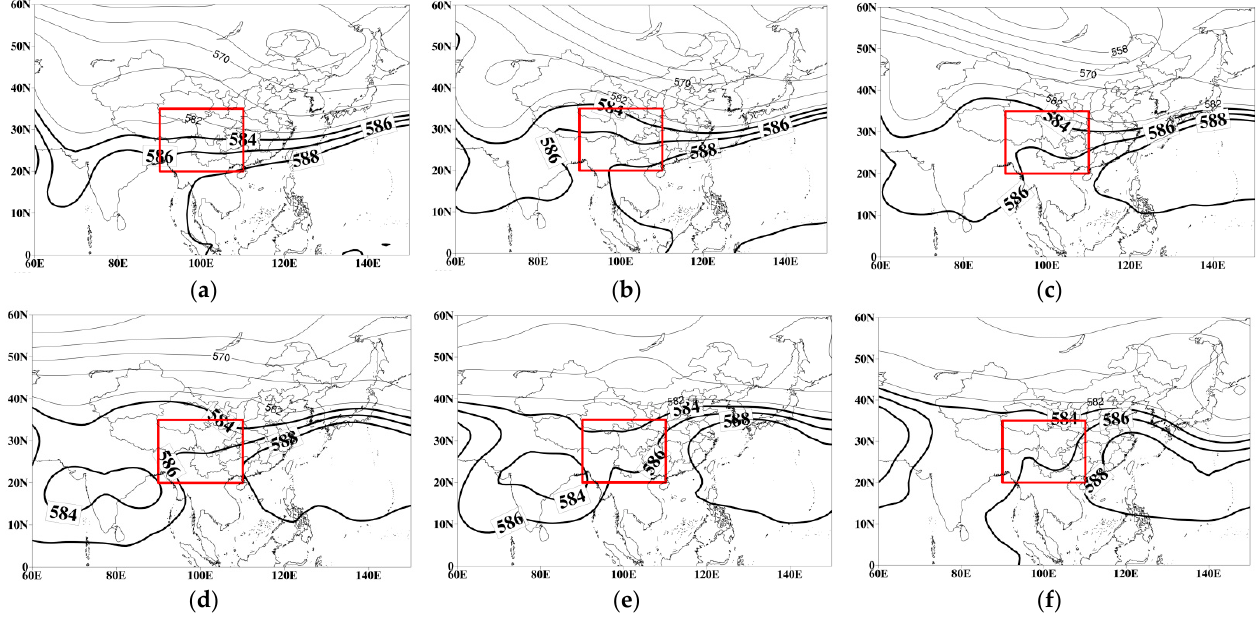
Figure 18. Homochronous 500 hPa height field in the first cycle of the 30–60 days ISO in 1998. (Unit: dagpm; ( a – f ) means phases 1–6; area in red box is southwest China).